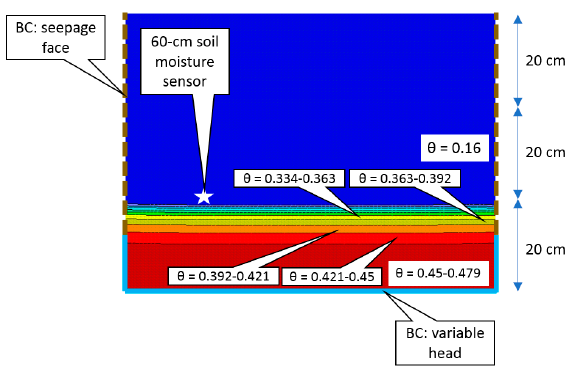
Figure 6. Modeled soil moisture ( θ ) in the deepest soil pit when the water level in the GI was highest (1330 h). Variable head boundary conditions are shown as a light blue line while seepage face boundary conditions are shown as a dashed brown line.